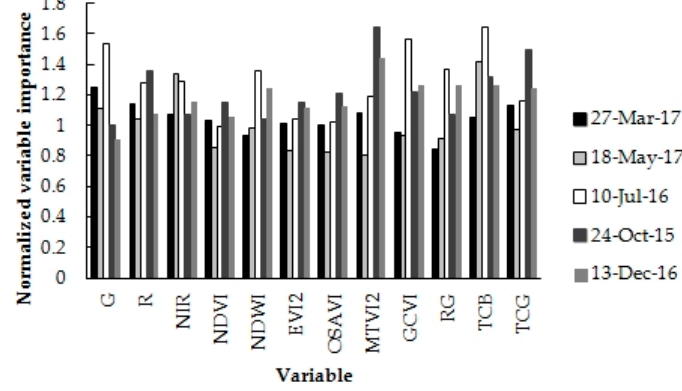
Figure 2. Predictive variable importance for the five individual season data.